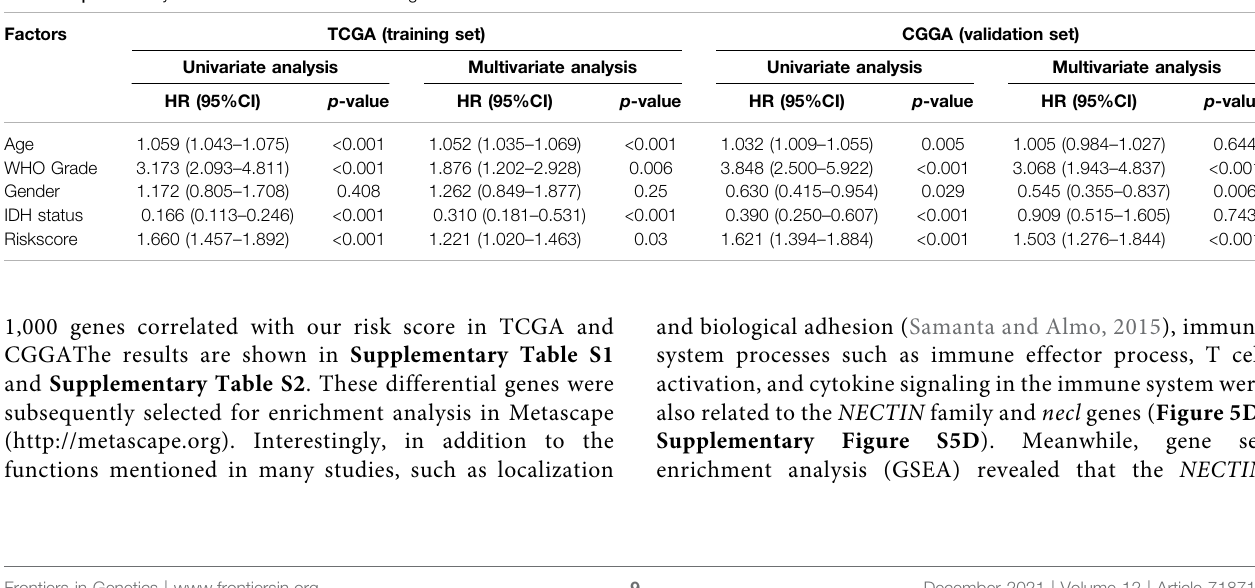
TABLE 3 | COX analysis of risk score in TCGA training cohort and CGGA validation